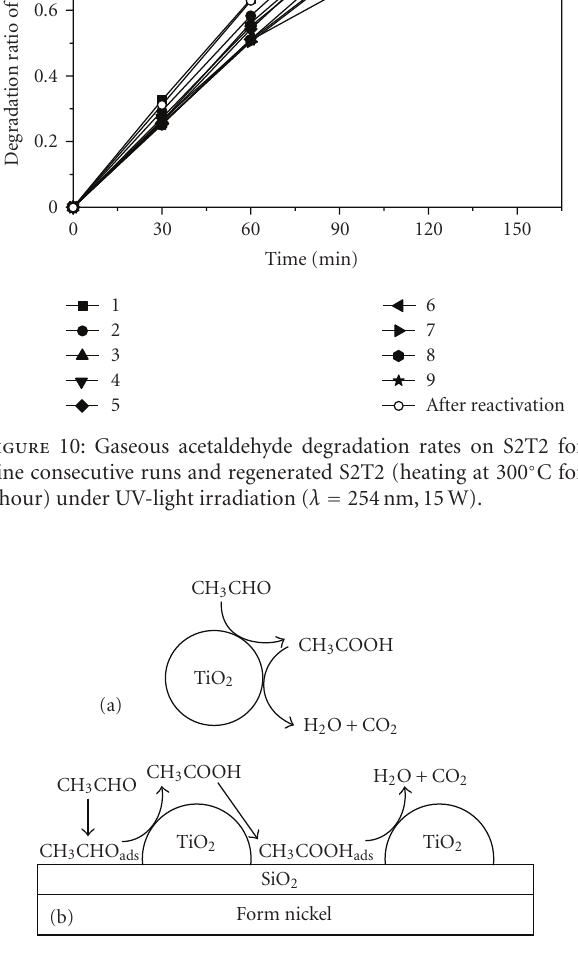
Figure 11: Schematic diagram of acetaldehyde photocatalytic de- composition on TiO 2 (a) and TiO 2 /SiO 2 (b)